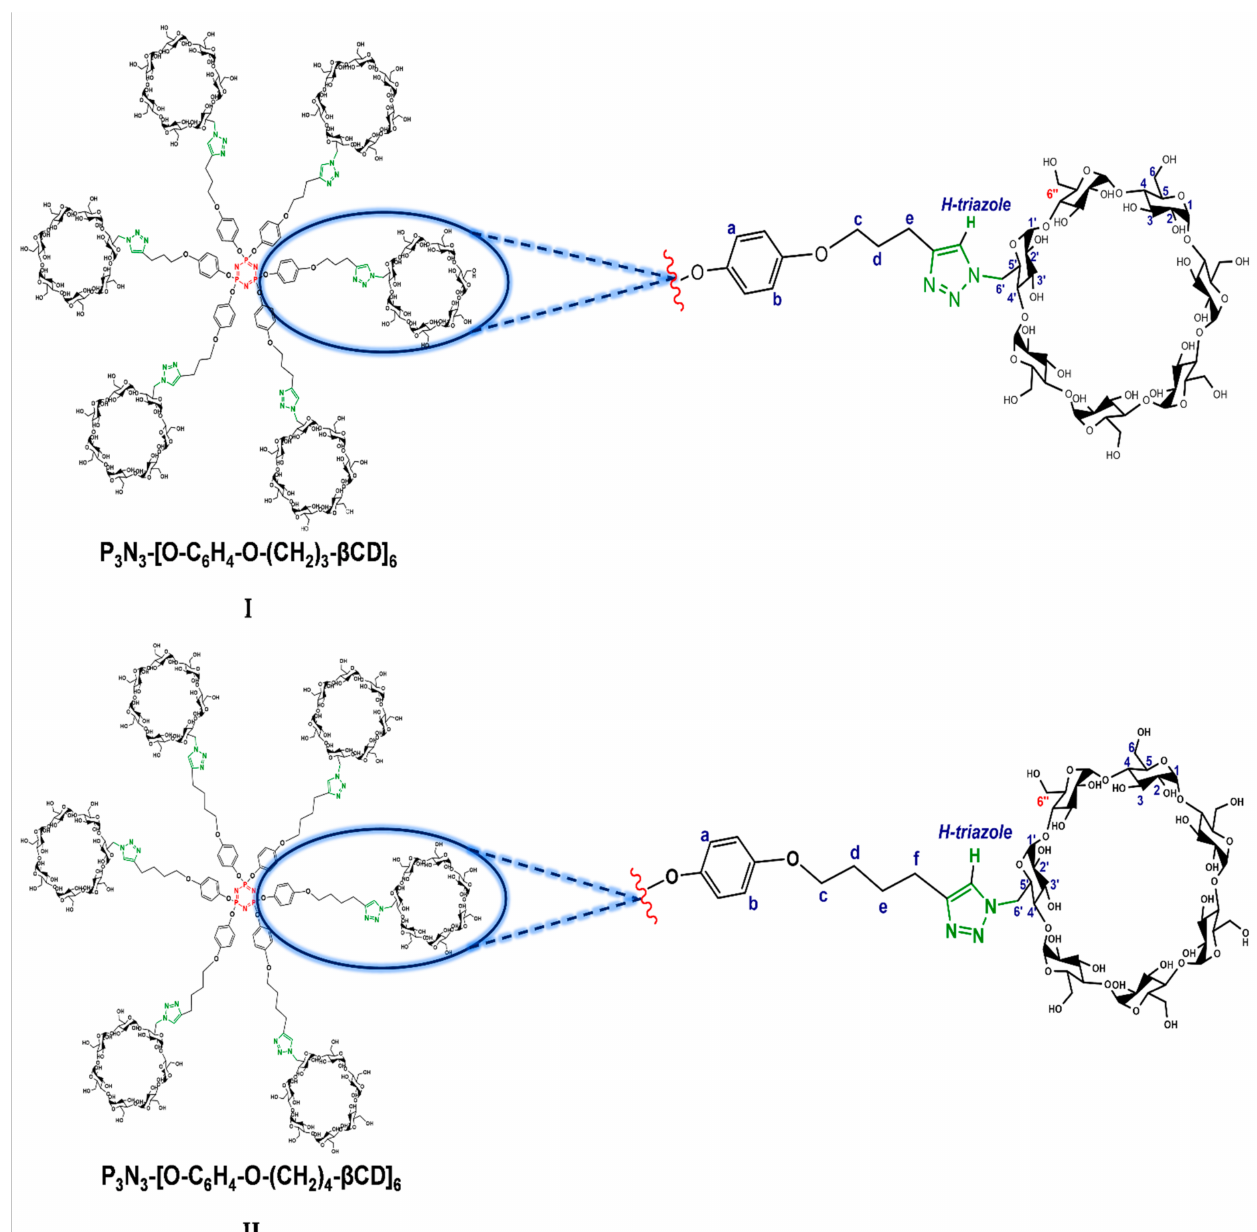
Figure 1. Structure of compounds P 3 N 3 -[O-C 6 H 4 -O-(CH 2 ) n - β CD] 6 , where n = 3 or and 4 ( I and II , respectively) and the representative assignment of the proton signals in